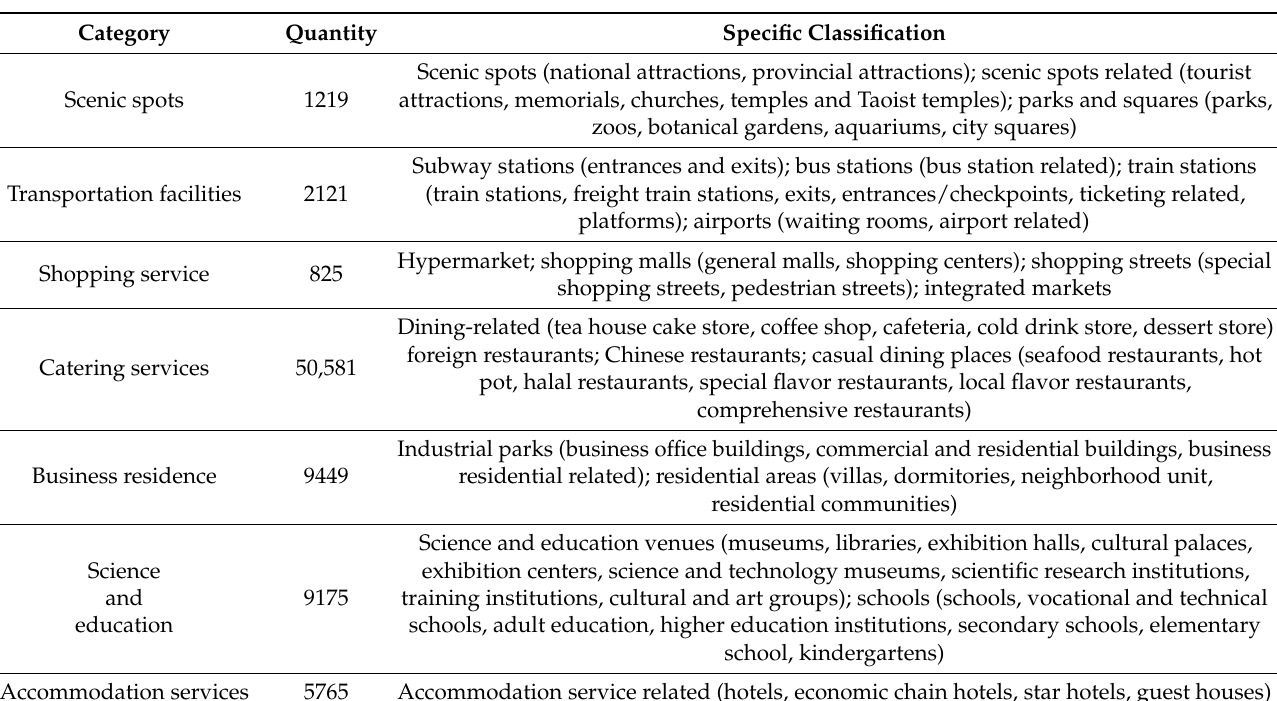
Table 2. Detailed list of POI data for seven